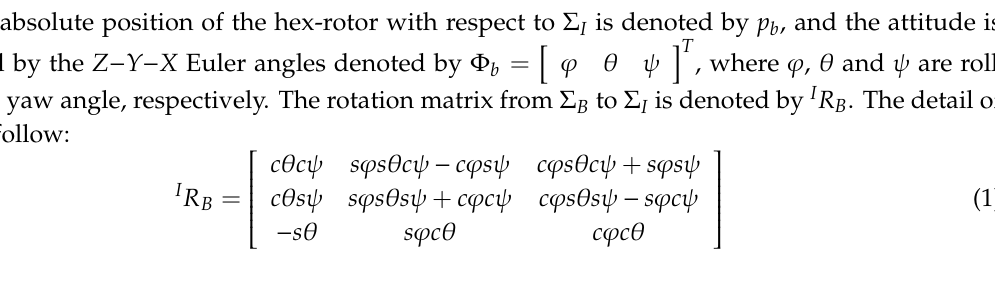
Figure 1. Frames in aerial manipulator system.